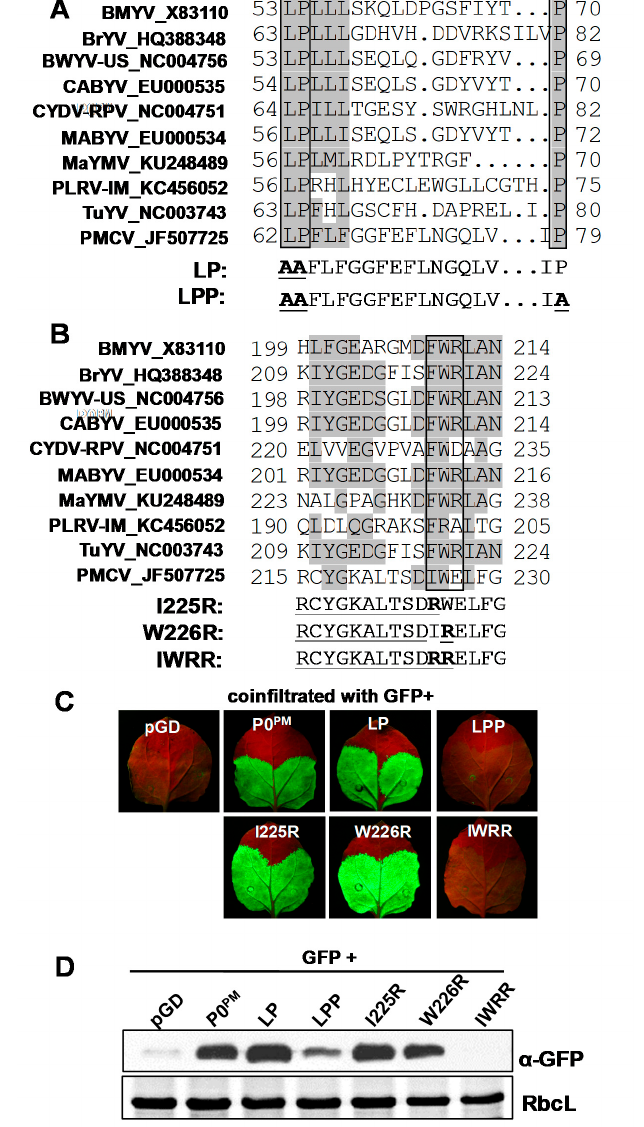
Figure 3. The critical residues in P0 PM motifs were required for its suppressor activity. ( A ) Multiple alignment of the F-box-like domains of P0 amino acid sequences from 10 poleroviruses. The region (amino acids 62 to 79) in P0 PM has homology to F-box-like domains. The LP mutant of P0 PM indicates a double mutation at amino acids 62 and 63 from LP to AA. The LPP mutant of P0 PM indicates a triple mutation at amino acids 62, 63, and 79 from LPP to AAA. ( B ) Multiple alignment of the FWR motif of P0 amino acid sequences from 10 poleroviruses. I225R mutant of P0 PM indicates the point mutation at amino acid 225 from I to R. W226R mutant of P0 PM indicates the point mutation at amino acid 226 from W to R. The IWRR mutant of P0 PM indicates a double mutation at amino acids 225 and 226 from IW to RR. ( C ) Agroinfiltration of N. benthamiana leaves with GFP plus empty vector pGD, LP, LPP, I225R, W226R, IWRR, or P0 PM . The empty vector pGD was used as negative control. Photographs were taken under long-wavelength UV light at 5 dpi. ( D ) GFP proteins from infiltrated leaf patches were detected by Western blotting at 5 dpi. GFP was detected with GFP polyclonal antiserum. RbcL is the Rubisco large